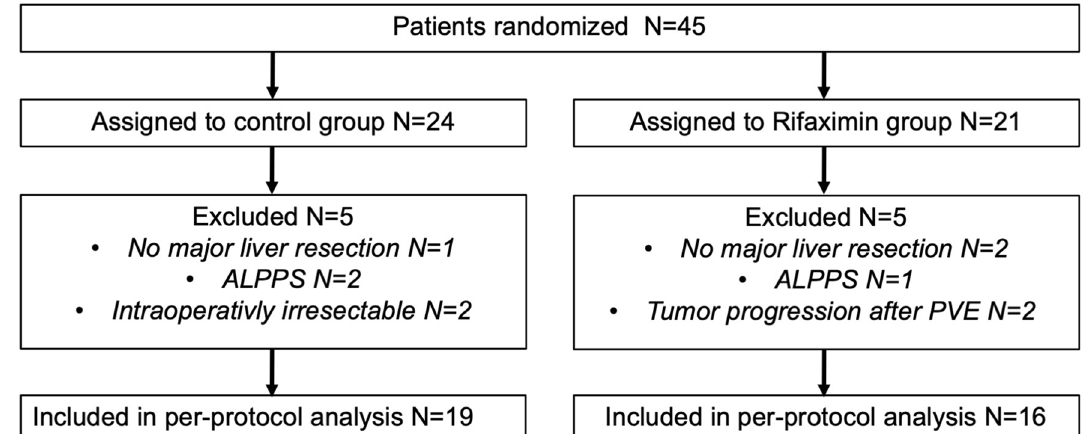
Figure 2. Trial profile. ALPPS, Associating liver partition with portal vein ligation for staged hepatectomy; PVE, portal vein